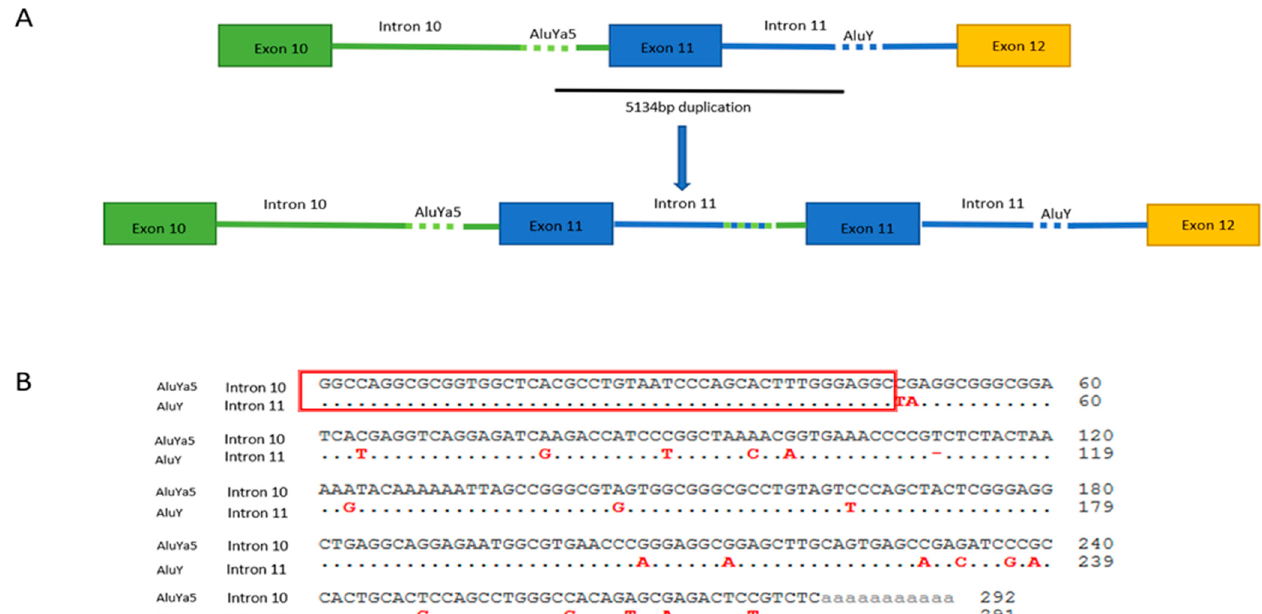
Figure 2. An Alu-mediated duplication mechanism appears to be responsible for exon 11 duplication. ( A ) Sequence analysis of the LR-PCR product allowed us to identify the duplication conjunctions that are located between c.3114-811 and 3202-1756. The location and orientation of the primers used for specific-duplication PCRs are indicated by vertical arrows. ( B ) Sequence alignment of the two Alu elements involved in this PALB2 rearrangement showing that these two elements are highly